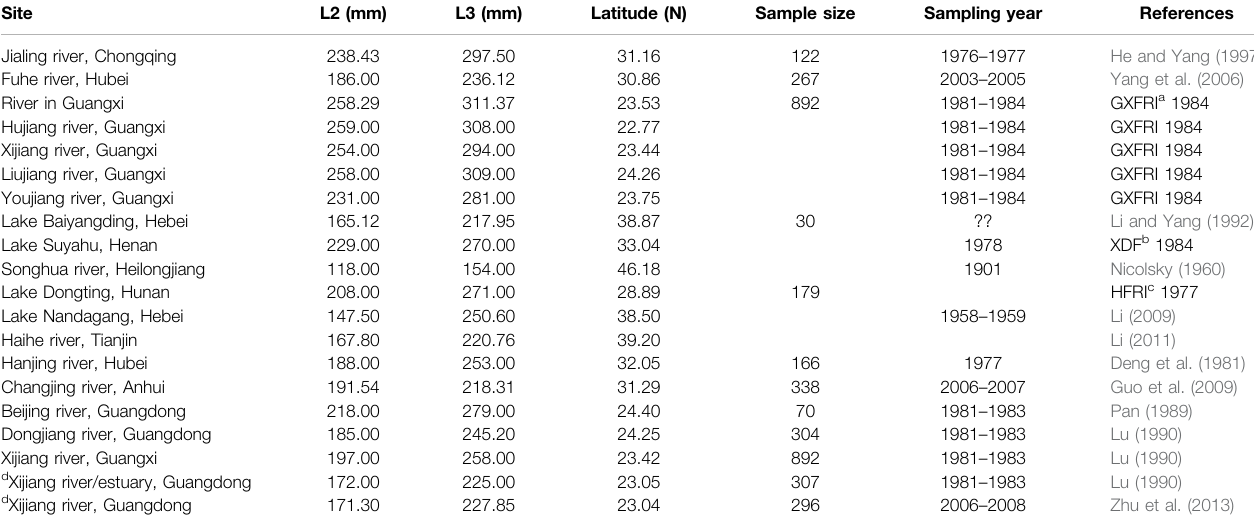
TABLE 1 | Length at age and sampling site for S. curriculus populations from China analysed in this study. L2 and L3 indicate length at the ages of 2 and 3 respectively.